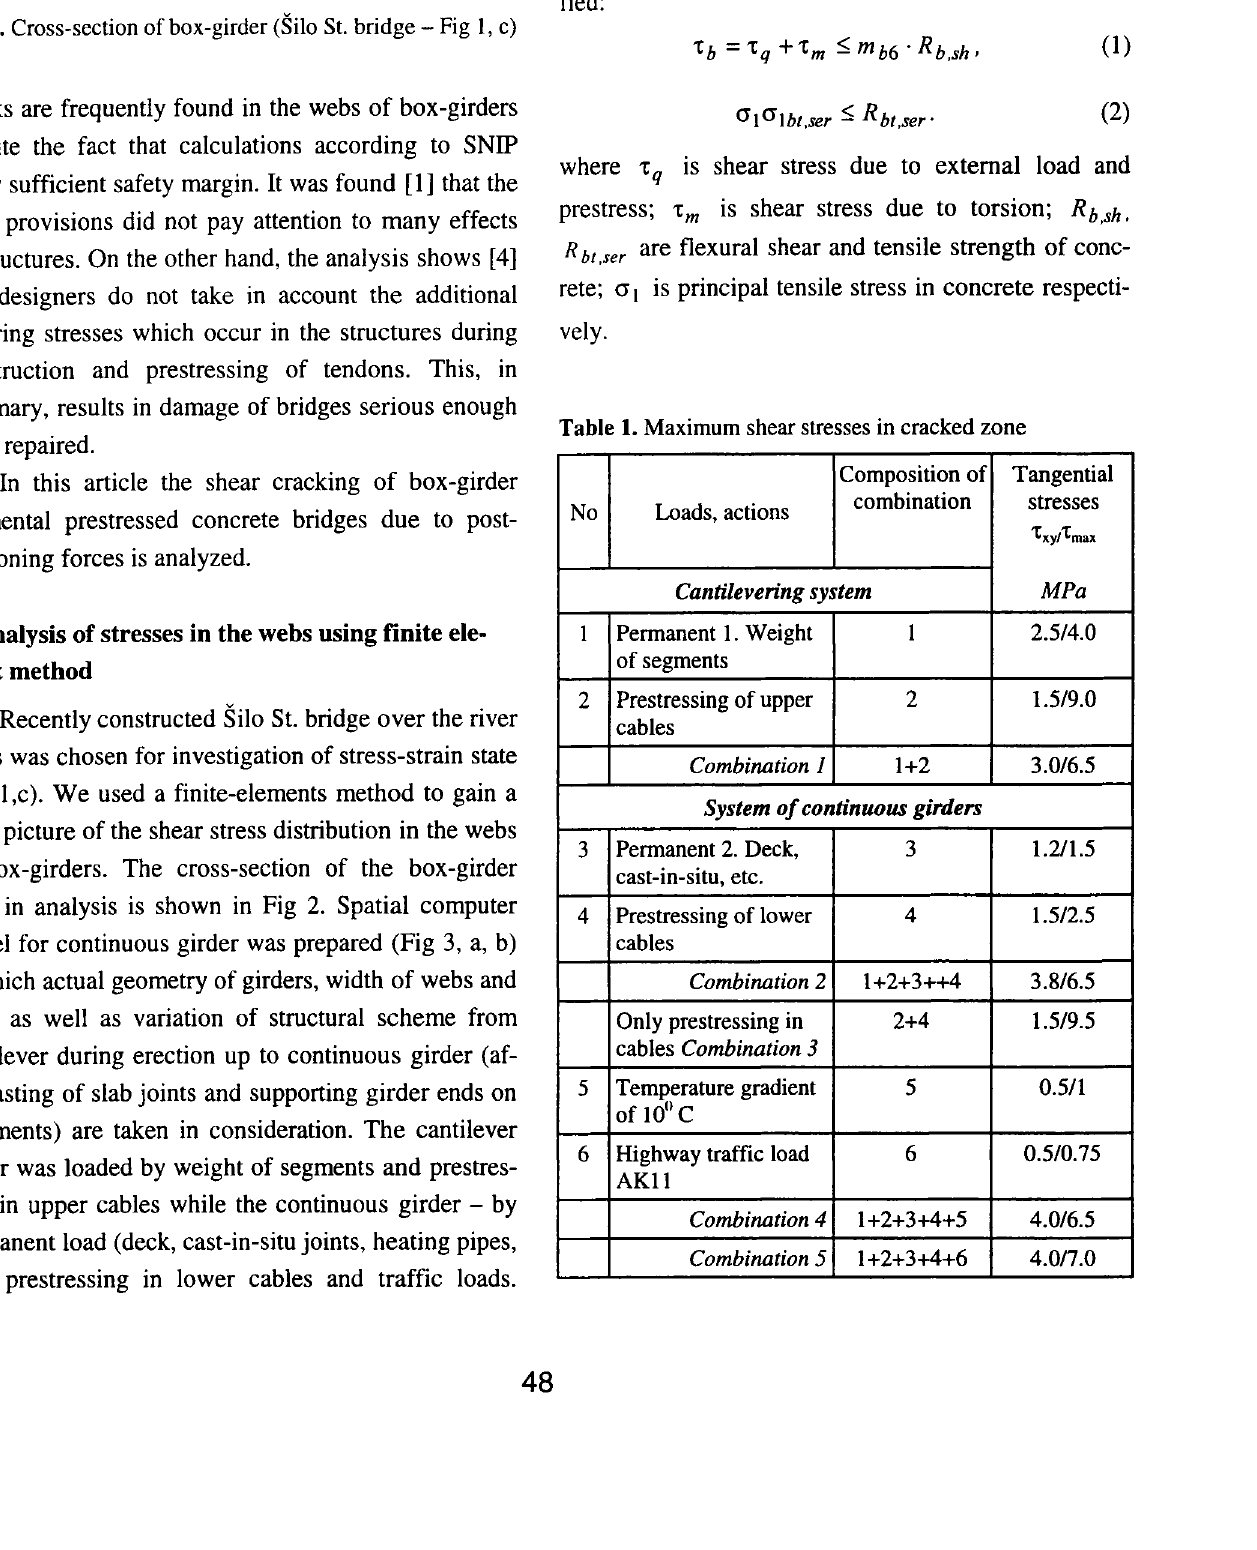
Fig 2. Cross-section of box-girder (Silo St. bridge - Fig I, c)